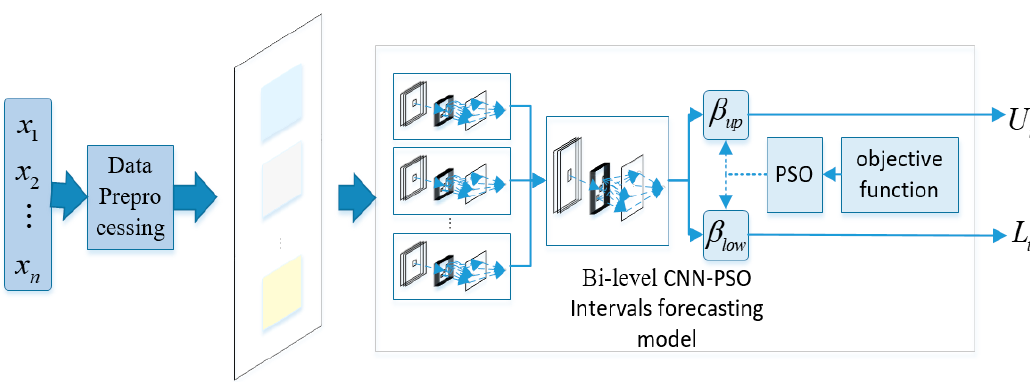
Figure 2. Interval forecasting mode. PSO: particle swarm optimization.